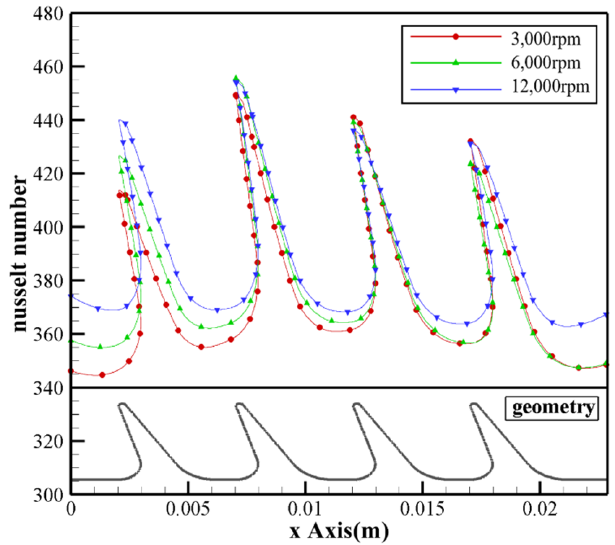
Figure 18. Temperature distribution on tooth surface.